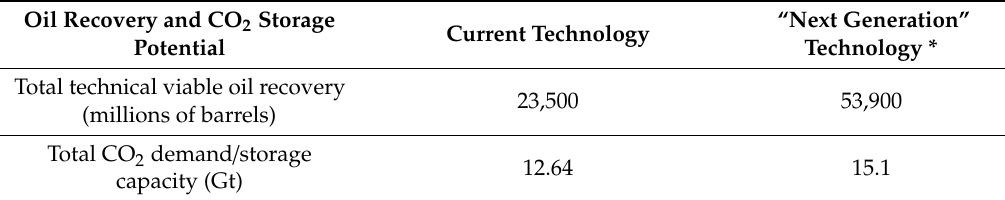
Table 3. US Gulf of Mexico technical oil recovery potential and associated CO 2 storage potential with current and “next generation” technologies